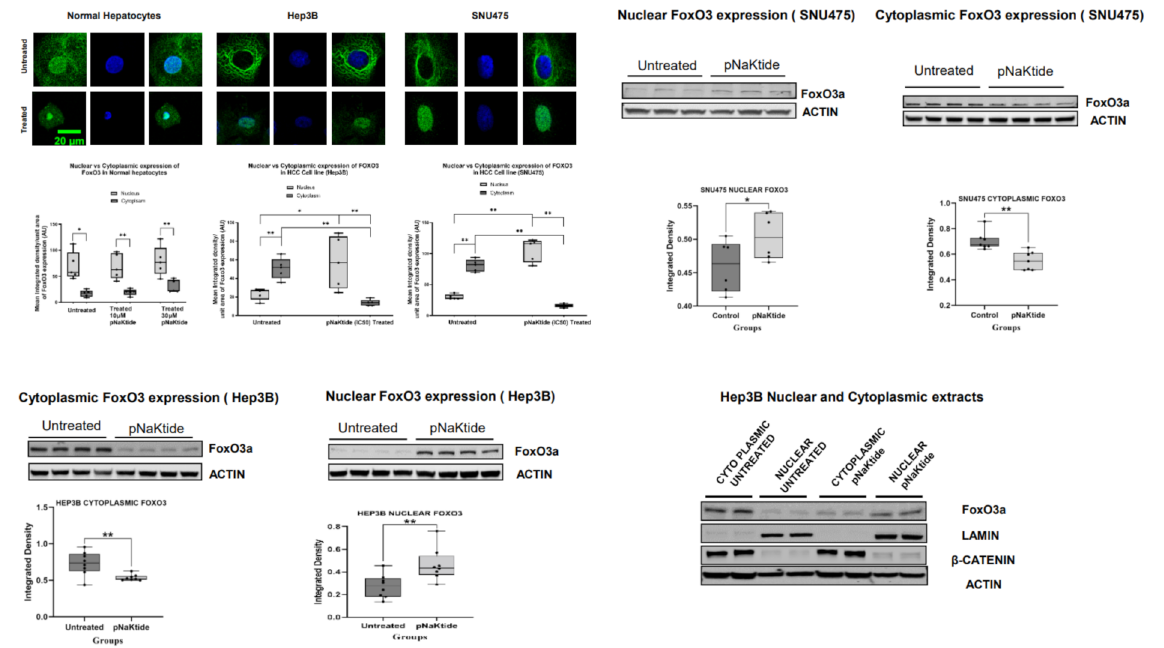
Figure 7. Effect of α 1-Na/K-ATPase signalosome normalization on nuclear/cytoplasmic expression of FoxO3. Nuclear/cytoplasmic expression of FoxO3 in pNaKtide-treated vs. -untreated human normal hepatocytes and HCC cell lines cells (* p < 0.05, ** p < 0.01, paired t -test, n = 5). Notice the significant nuclear localization and low cytoplasmic expression of FoxO3 in normal hepatocytes and in pNaKtide-treated HCC cells compared with the untreated cells. Additionally, note the expression of nuclear LAMIN and cytoplasmic β -CATENIN in western blots, confirming success of nuclear/cytoplasmic